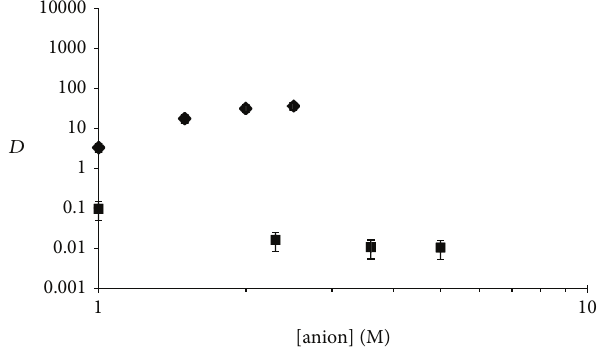
, ( ◼ ) [ Cl − ] . Organic phase was tot tot